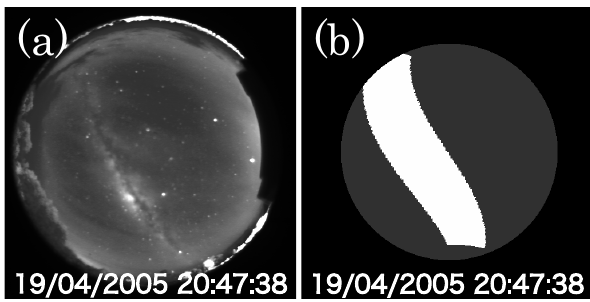
Fig. 1. (a) Example of an all-sky OH airglow image obtained at Kototabang on 19 April 2005 (20:47UT). (b) All-sky Milky Way area modeled for the same time.